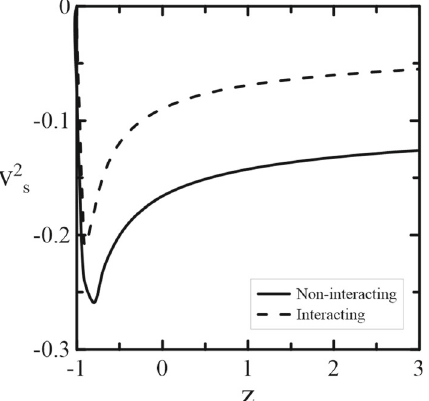
Fig. 7 The power spectrum of cosmic microwave background anisotropy of interacting and non-interacting THDE models with con- sideration of the Hubble horizon as IR cutoff compared to the (cid:2) CDM.